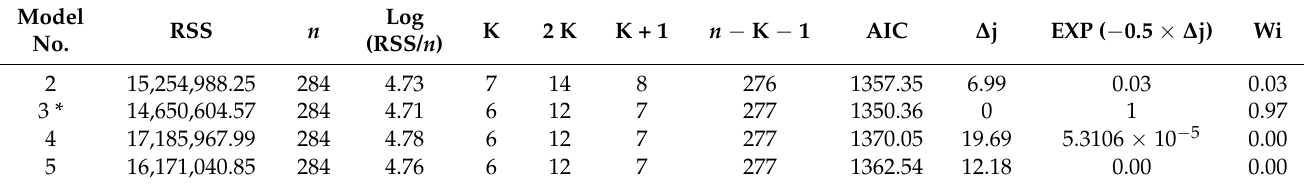
Table 3. Results of the inter-model comparison using the Akaike information criterion for soil-erosion regression models.